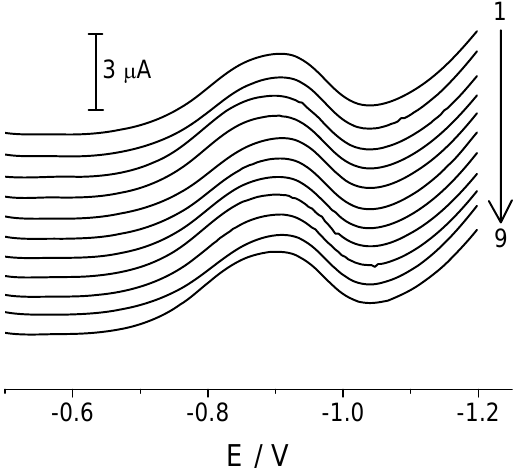
Figure 5. Reproducibility of the analytical signal for 22.4 μ g cm − 3 of clothianidin at BiF-GCE in 30 min time interval. Other experimental parameters are the same as in Figure